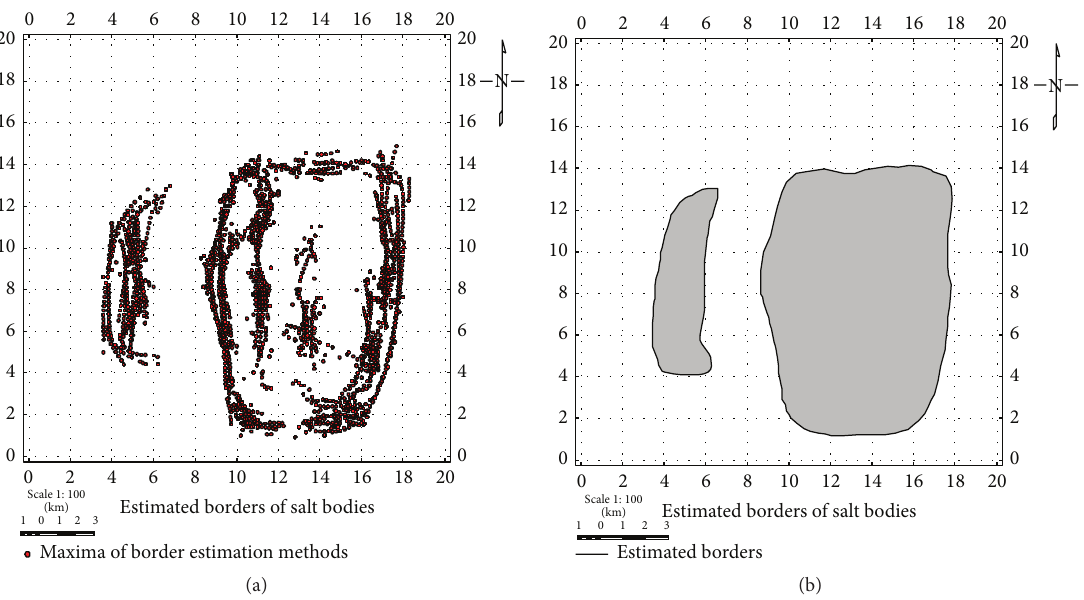
Figure 6: (a) Maxima location estimated from the methods depicted in Figure 5 and (b) sources in a plan view as interpreted from those maxima.